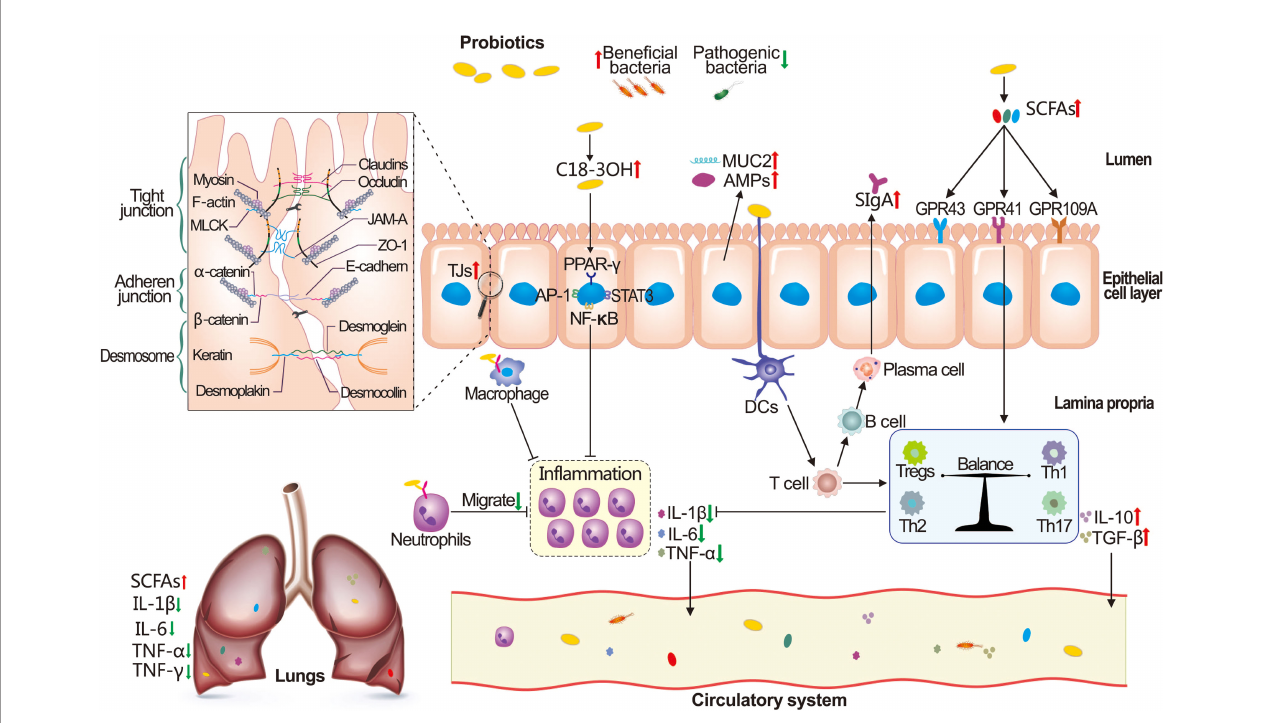
FIGURE 6 | Possible mechanisms of probiotics supplementation on PALI recovery. Probiotics can restore the function of the intestinal barrier by inhibiting the proliferation of pathogenic bacteria, increasing the production of 3-hydroxyoctadecenoic acid (C18-3OH), short-chain fatty acids (SCFAs), antimicrobial peptides (AMPs), mucin2 (MUC2), and secretory IgA (SIgA), and regulating the expression of tight junction (TJ) proteins. In addition, probiotics have the capacity to reduce the neutrophil in fi ltration and release of in fl ammatory cytokines, maintain the balance of the intestinal immune system, and reduce the translocation of bacteria, in fl ammatory factors, etc., resulting in the alleviation of